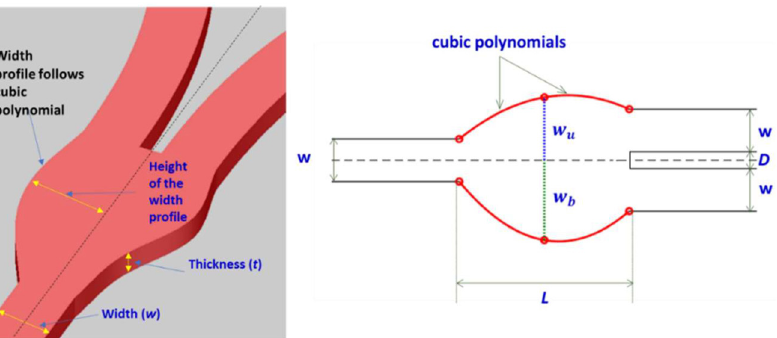
Figure 1: Schematic of the photonic power divider. The core material is silicon, and the cladding material is silica. (Left panel): three-dimensional illustration. (Right panel): planar layout.